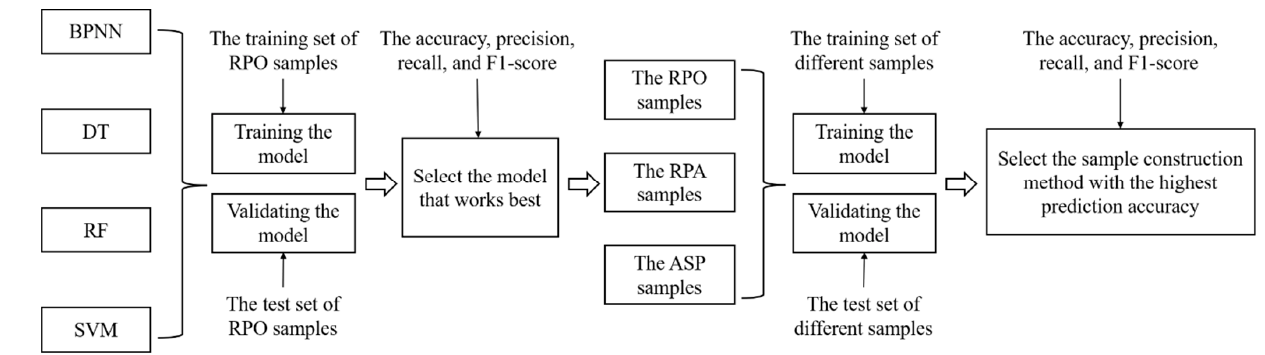
Figure 4. Map showing the establishment of research program.